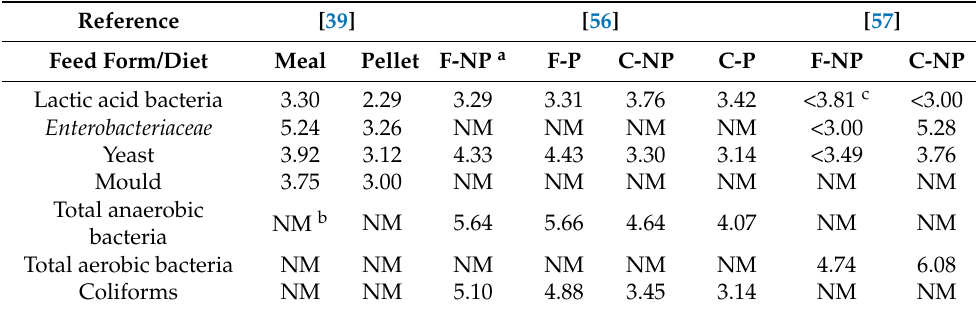
Table 2. Microbiological data (log 10 CFU/g) from experimental meal and pelleted diets (finely or coarsely ground)